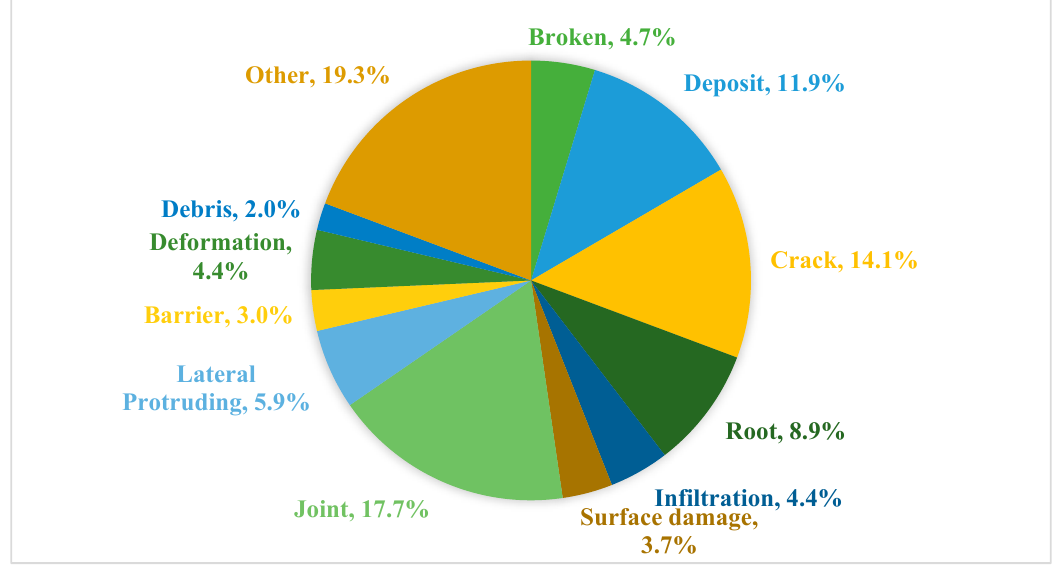
Figure 14. Studies on sewer inspections of different classes of defects.